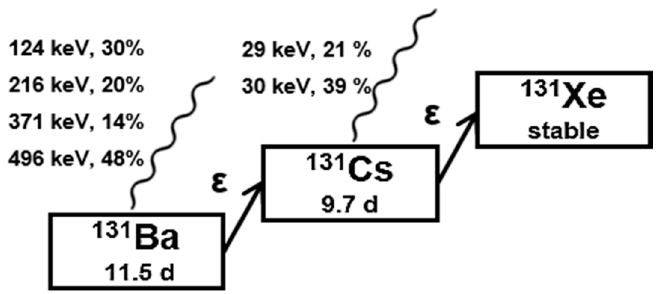
Figure 1. Decay scheme of barium-131.